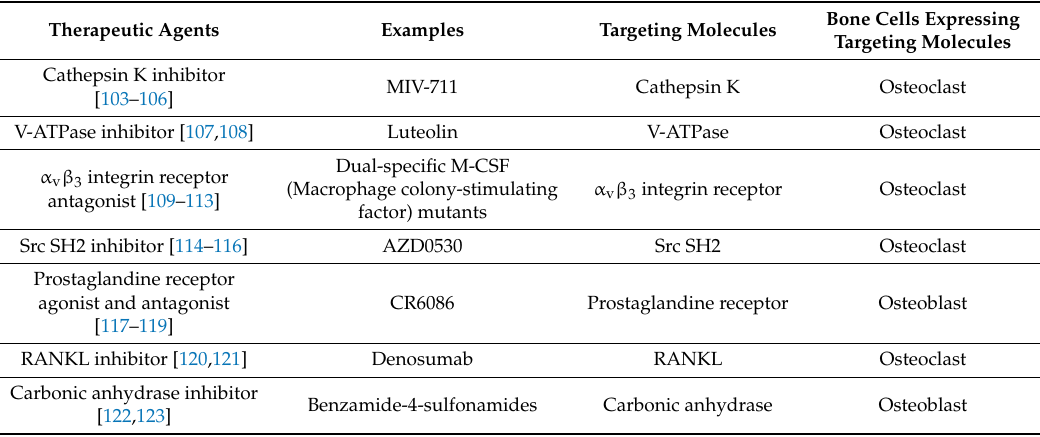
Table 2. Therapeutic agents targeting different molecules in bone